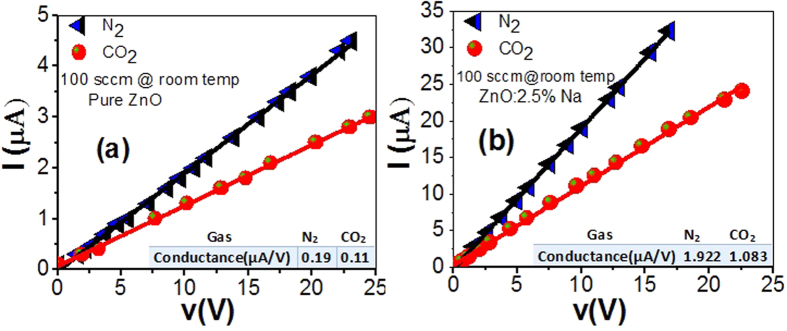
I–V characteristics of (a) pure and (b) 2.5% Na – doped ZnO sensors to CO2 and N2.